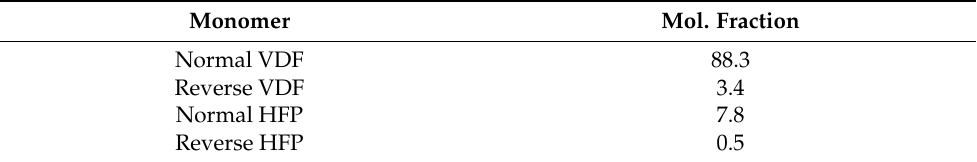
Table 1. Composition of the P(VDF-HFP) copolymer established by NMR 19 F data [34].